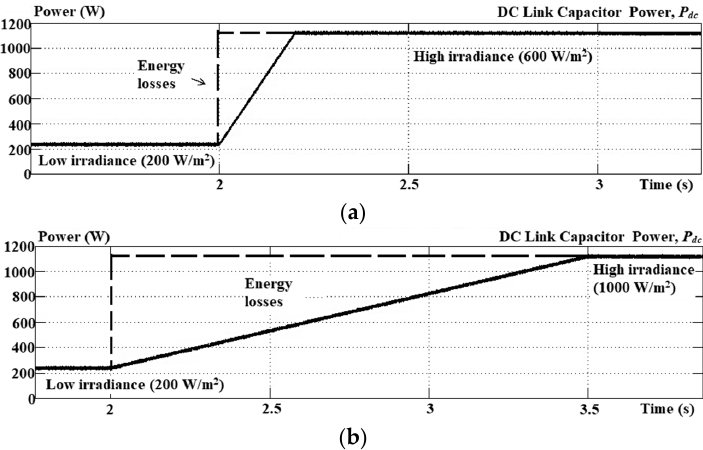
Figure 13. Simulation results of DC link capacitor power under low to high irradiance using ( a ) step size error cancellation and ( b ) direct control in self-charging algorithms. Table 3. Total Harmonics Distortions (THDs) of current harmonics extraction algorithms in simulation work with different irradiances.